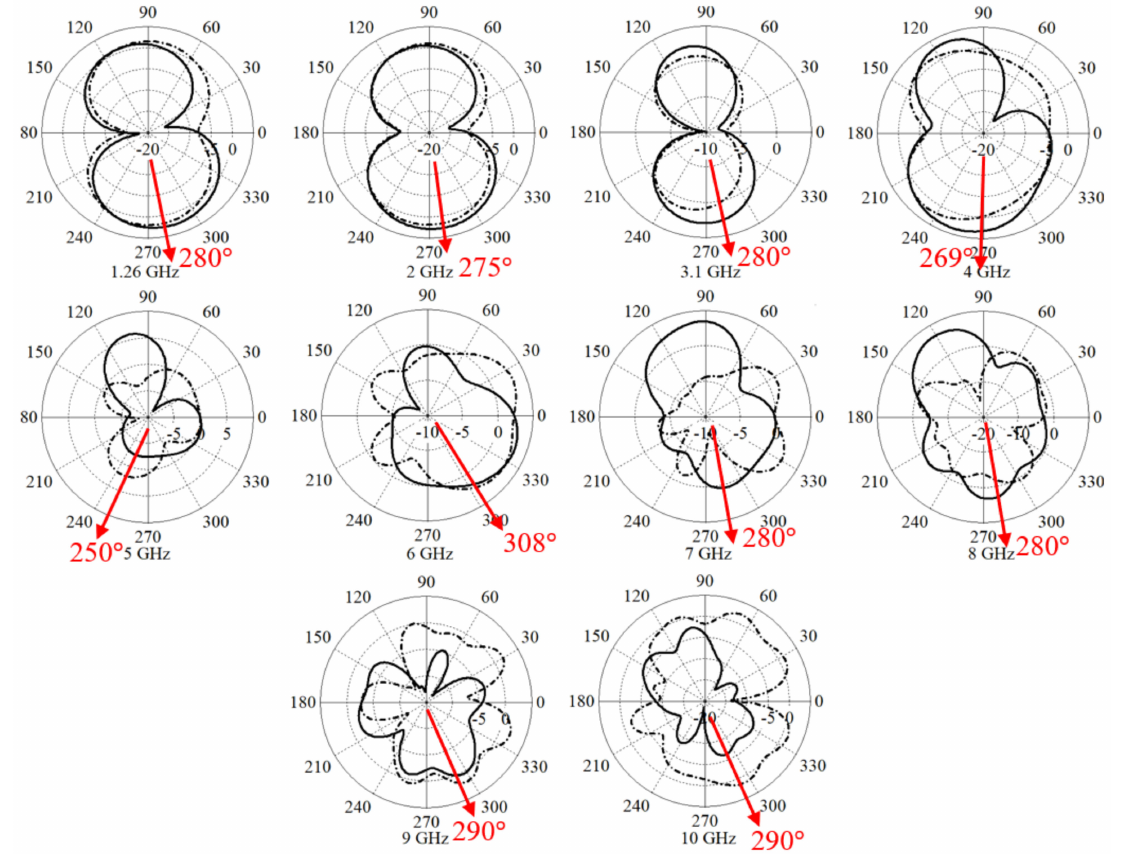
Figure 6. E-field and H-field of the far-field radiation